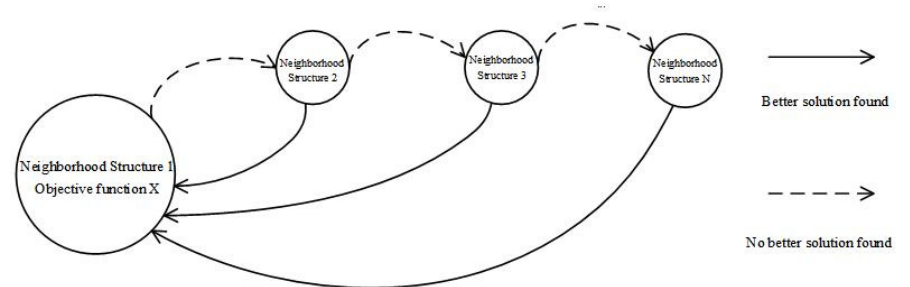
Figure 5. Illustration of the perturbation process.